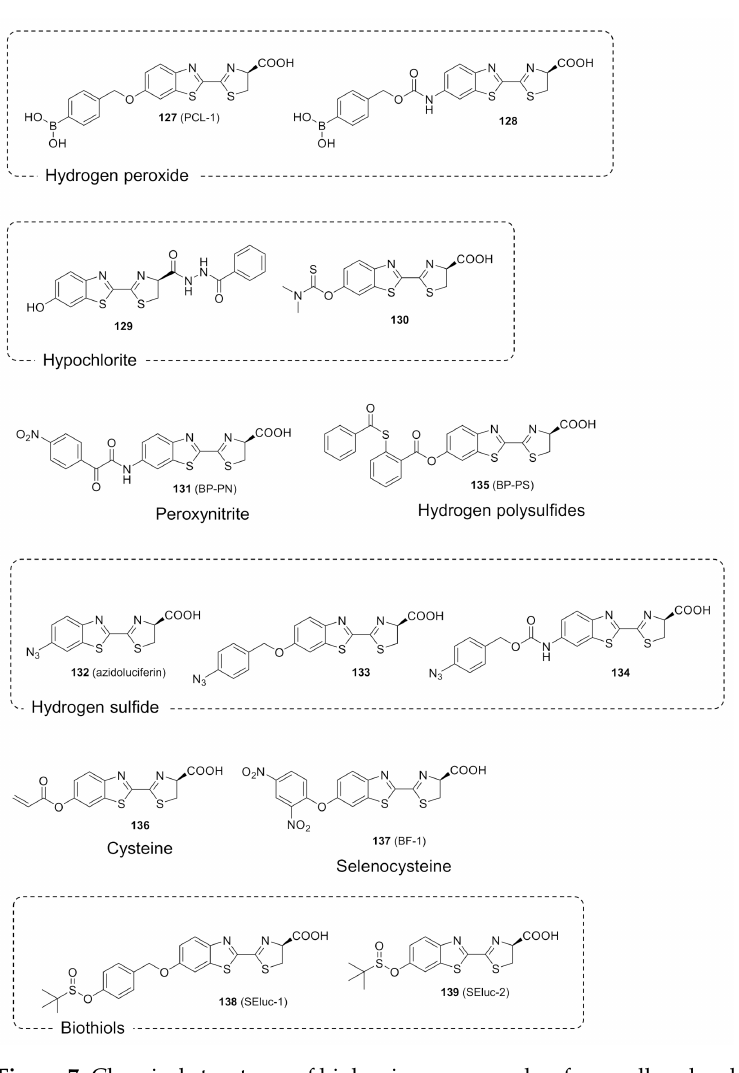
Figure 7. Chemical structures of bioluminescence probes for small molecules.